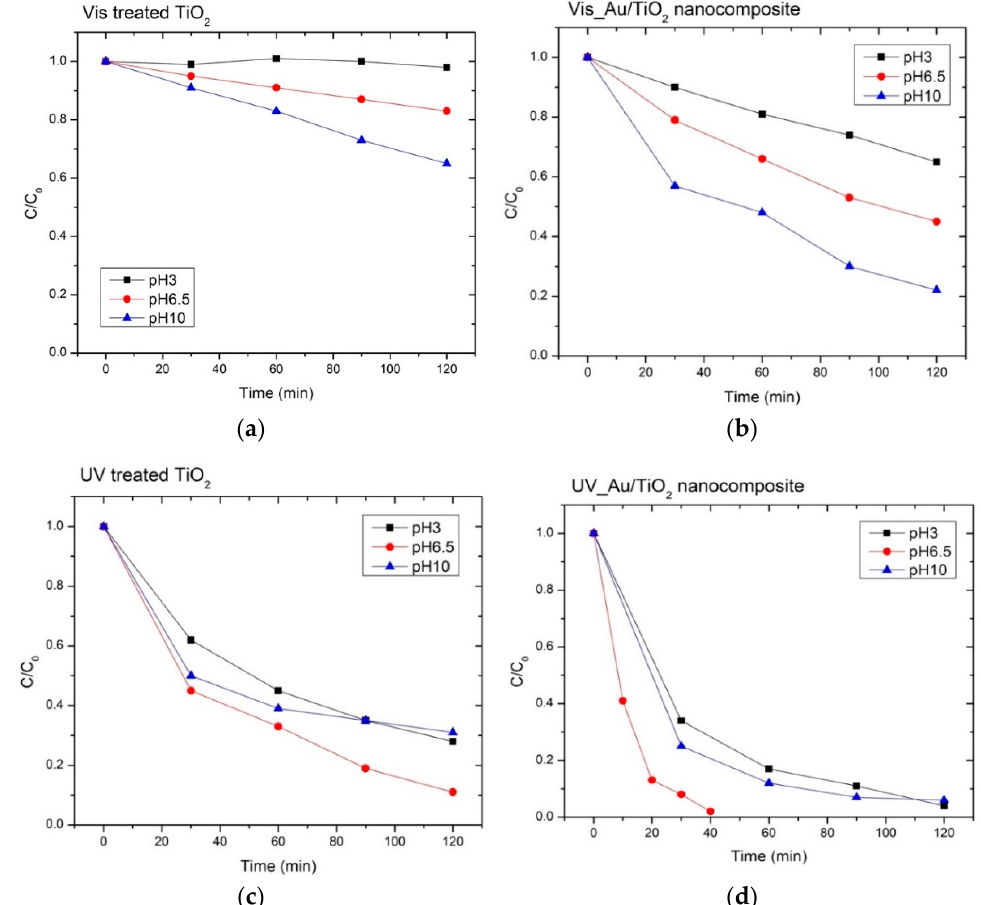
Figure 6. Photocatalytic degradation of MB under visible light irradiation with ( a ) treated TiO 2 and ( b ) Au/TiO 2 nanocomposite and UV light irradiation with ( c ) treated TiO 2 and a ( d ) Au/TiO 2 nanocomposite at different pH values.